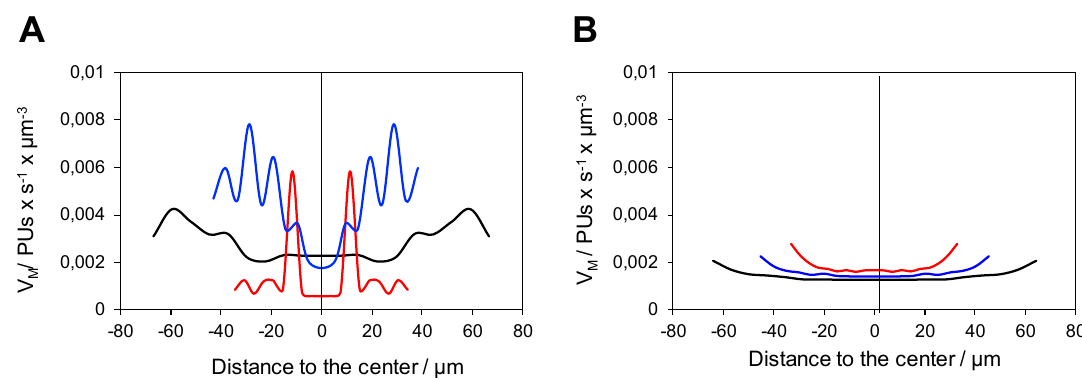
Figure 6. Profile of apparent V M along the radius of His-BsADH co-immobilized with either NADH ( A ) or NAD+ ( B ) using acetone and benzaldehyde as substrates, respectively. The profiles of V M were analyzed for three single beads with different radii 64–66 µm (black), 43–45 µm (blue), and 33–34 µm (red). Reactions were triggered by the addition of the 10 mM or the organic substrate (acetone or benzaldehyde) in 10 mM Tris-HCl pH 7 at 25 °C.